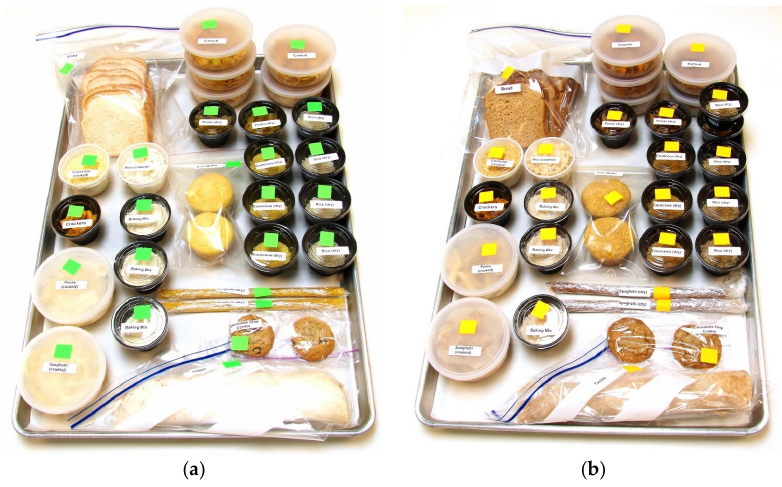
Figure A1. Images of the 2000 kcal market baskets: ( a ) the refined grain basket; and ( b ) the whole grain basket.